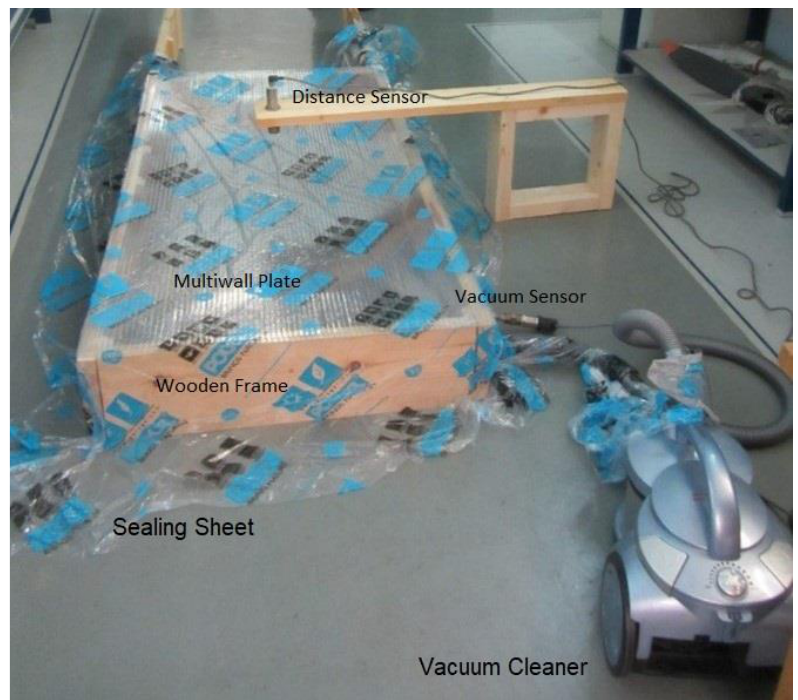
Figure 4. The vacuum chamber test set.